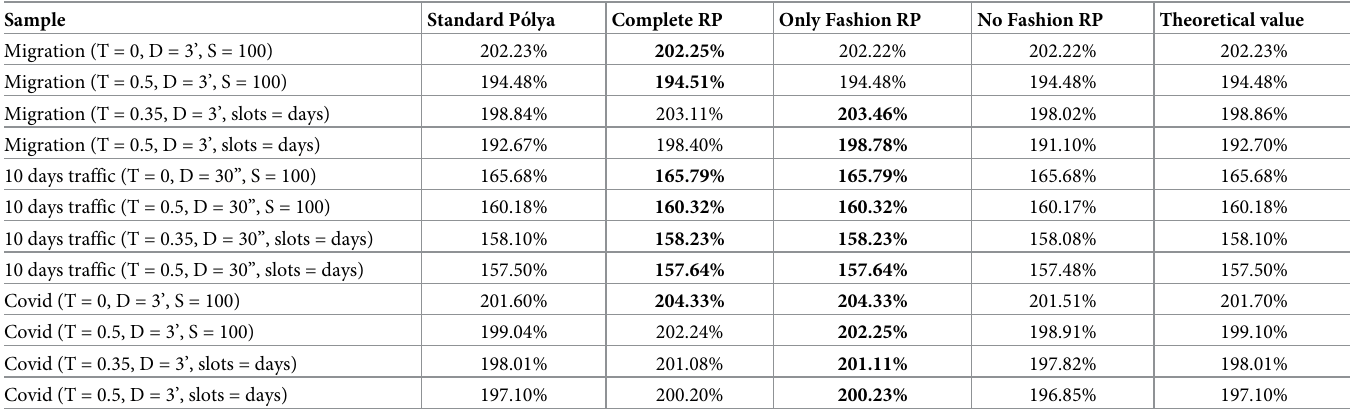
Table 13. Comparison of the different considered models in terms of (6).